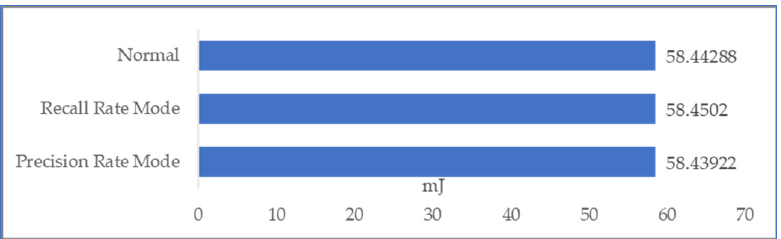
Figure 11. The communication cost of using 3 different strategies.